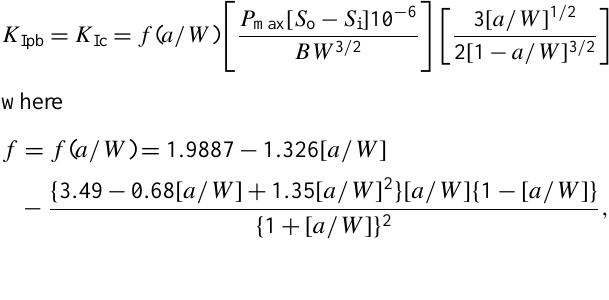
Figure 7. Schematic of four-point bending arrangement used to de- Figure 4. Schematic of four-point bending arrangement used to de- termine the critical fracture toughness. termine the critical fracture toughness. Figure 5. Representative central load and load-point displacement